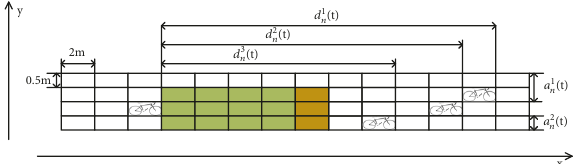
Figure 3: Illustration of the schematic diagram of cells on bicycle roadways.